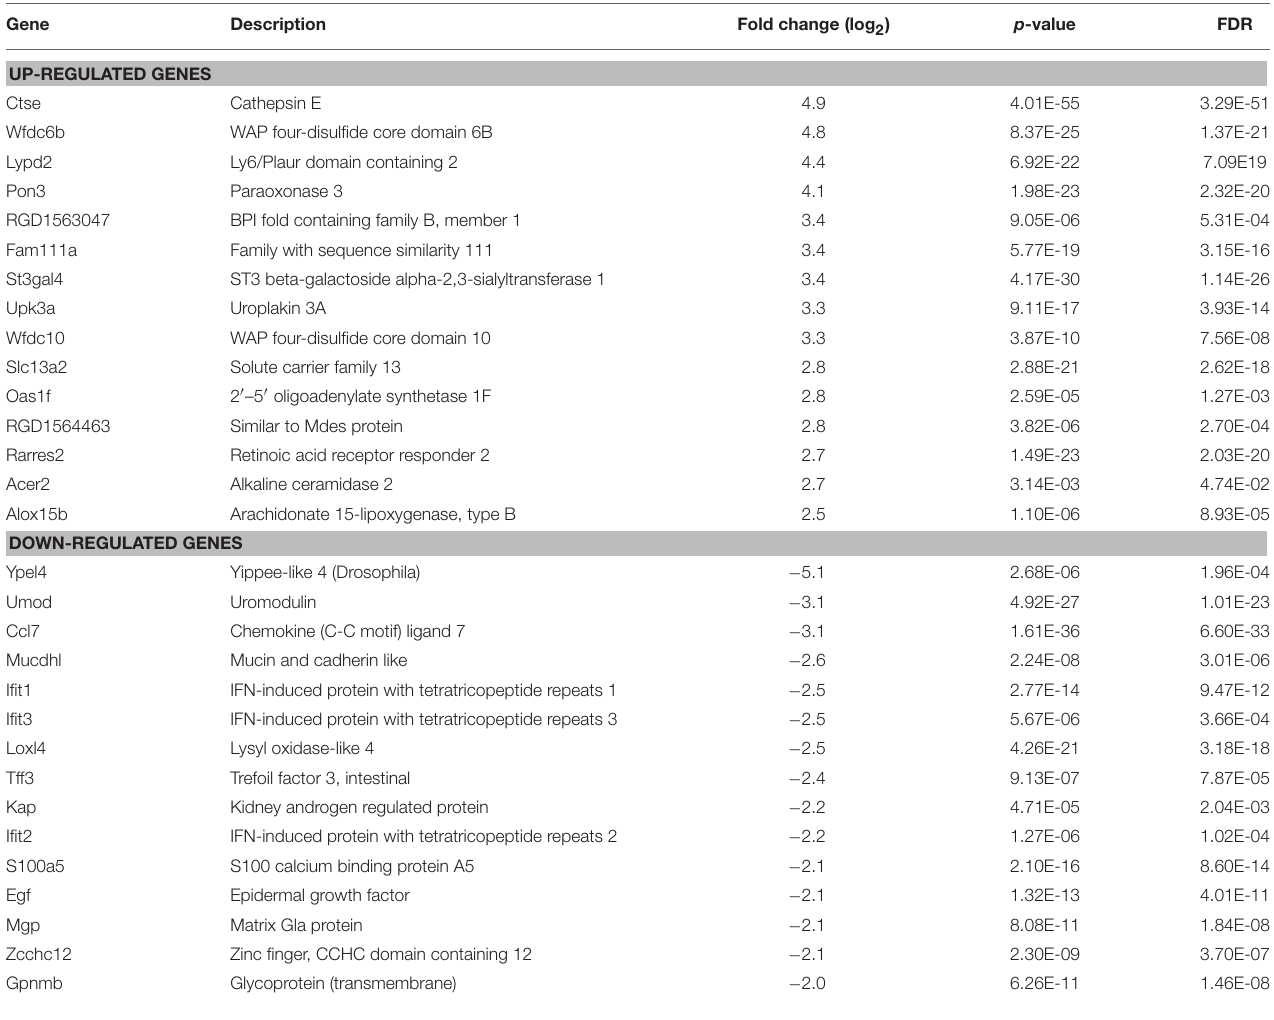
TABLE 1 | The top 15 up- and down-regulated genes in STZ rat IM by RNA-seq